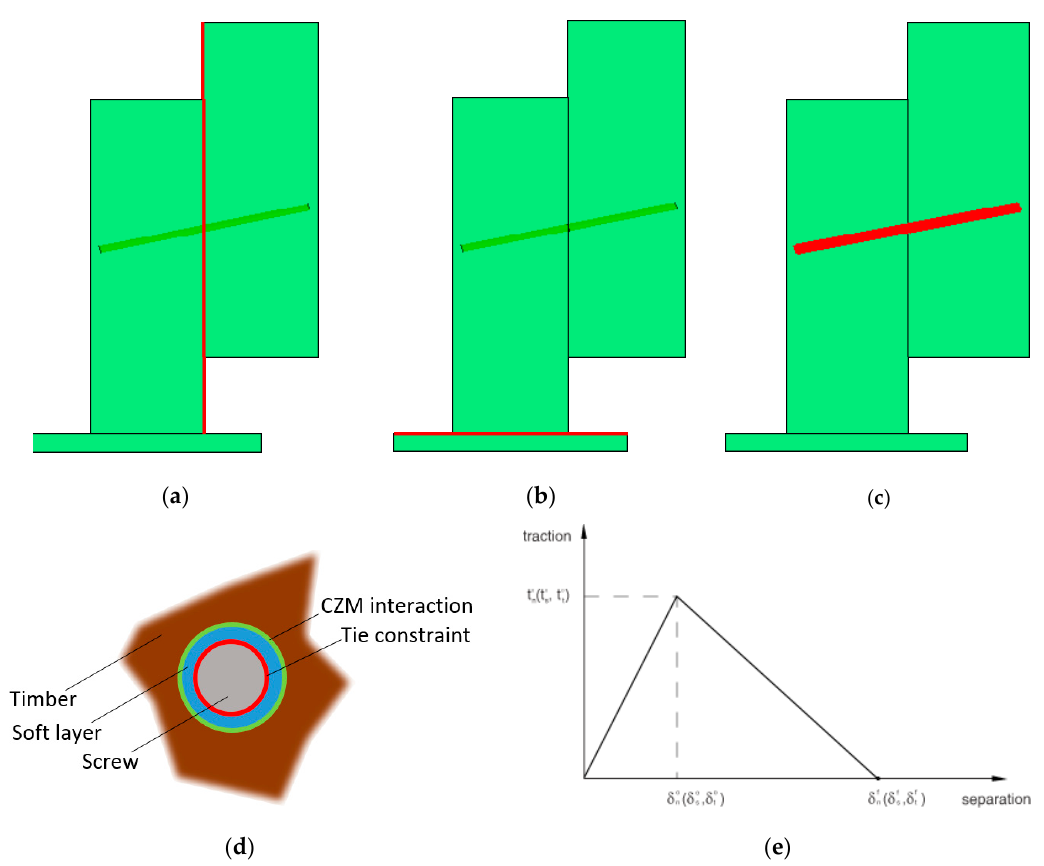
Figure 6. FE modelling TTC joints with inclined STSs under a standard PO setup. In evidence, the mechanical contact interactions for: ( a ) timber-to-timber, ( b ) base support and ( c , d ) STS details (hidden mesh pattern), with ( e ) traction-separation law.